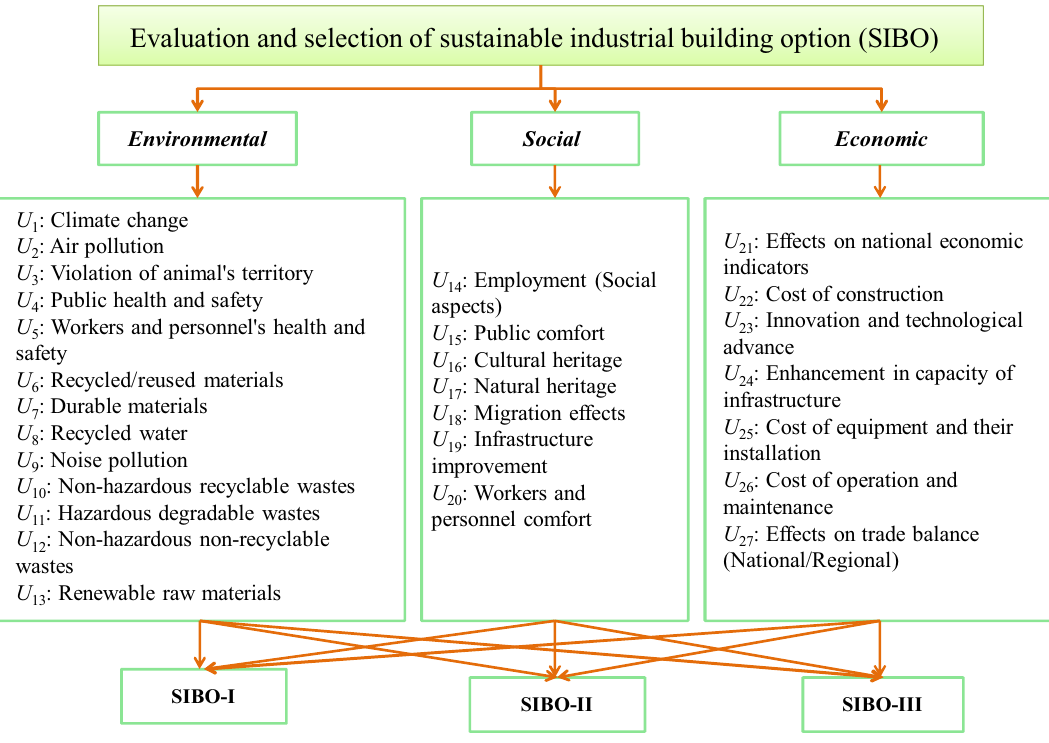
Figure 1. Research framework of selection sustainable industrial building